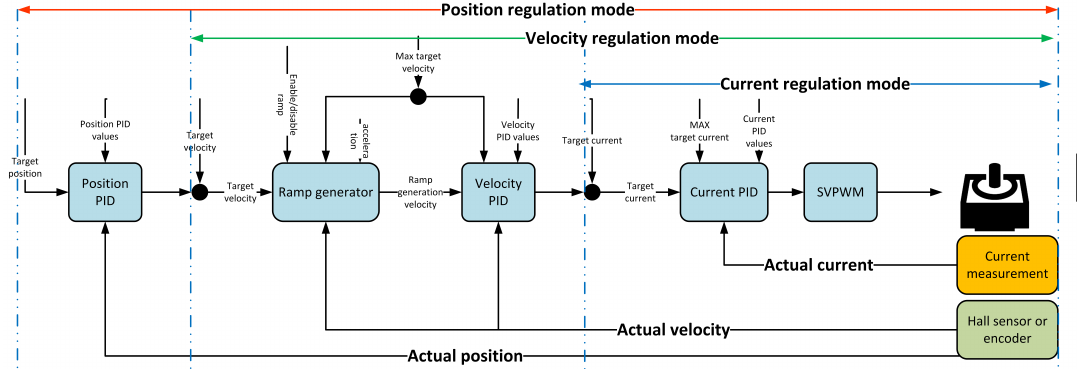
Figure 7. Cascaded PID regulation of the joint’s motor TMCM-1610-KR controller